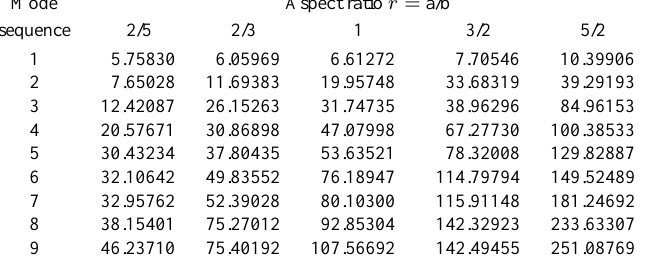
Table 11 Bicubic B-spline solutions of frequency parameters for CSGF